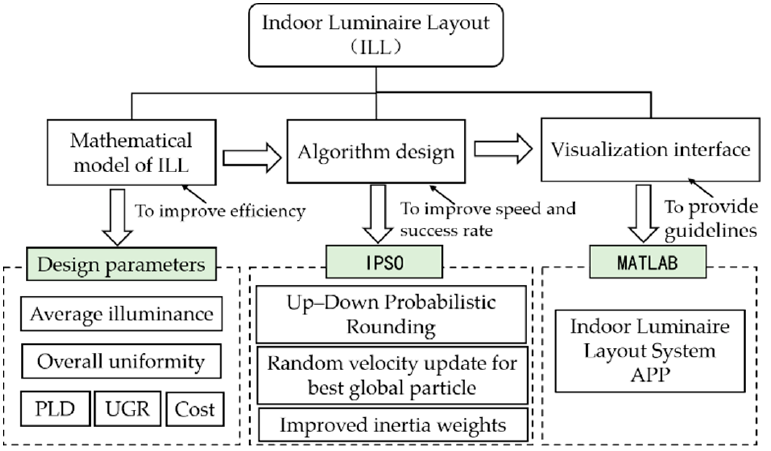
Figure 1. Structure graph of the method.